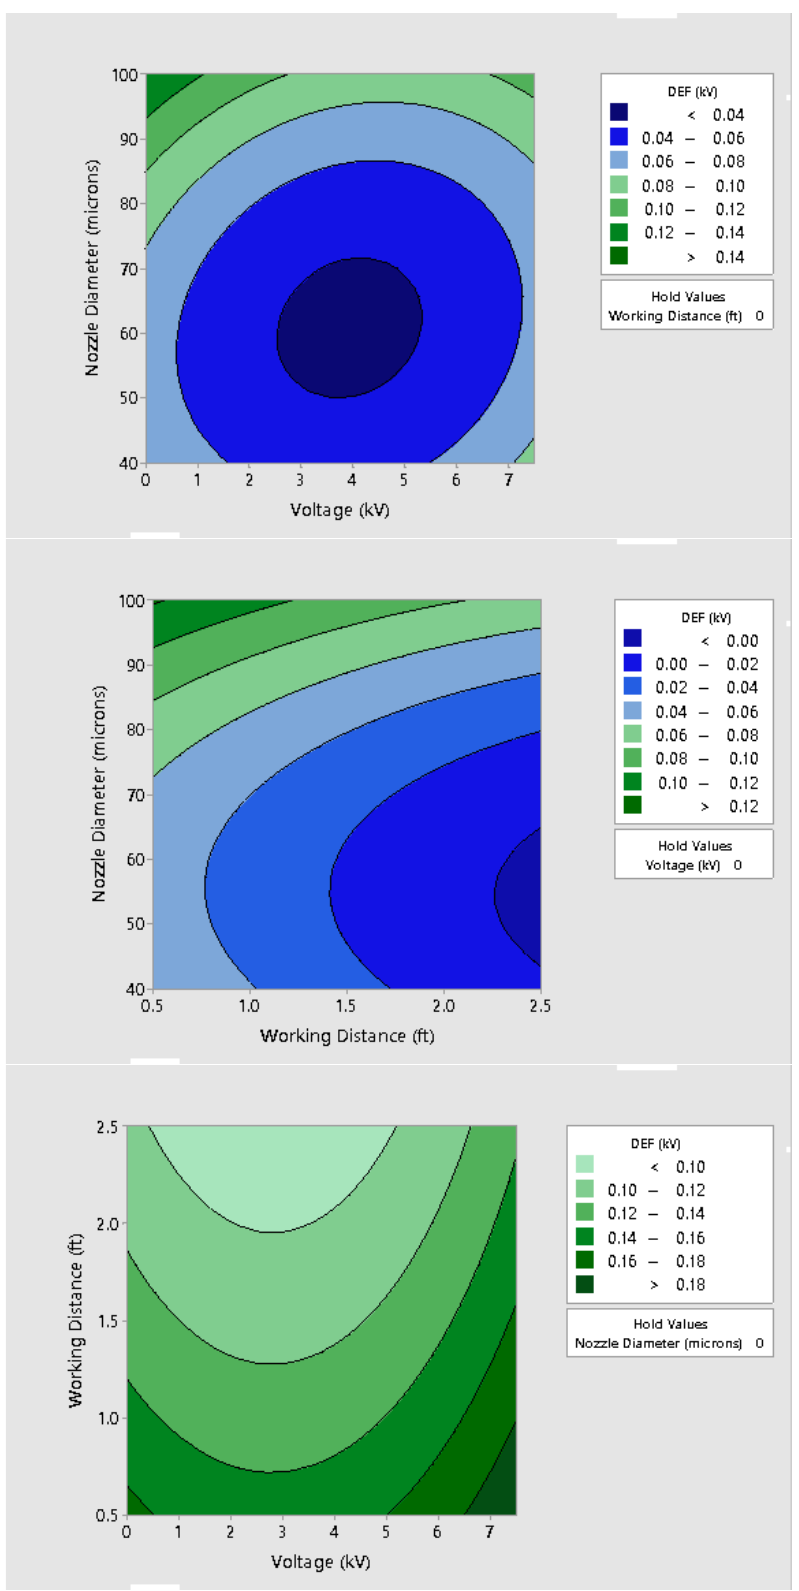
Figure A14. Cast iron: quantitative representation of average differential electric field vs. working distance (feet), nozzle sprayer size ( µ m), and charge voltage